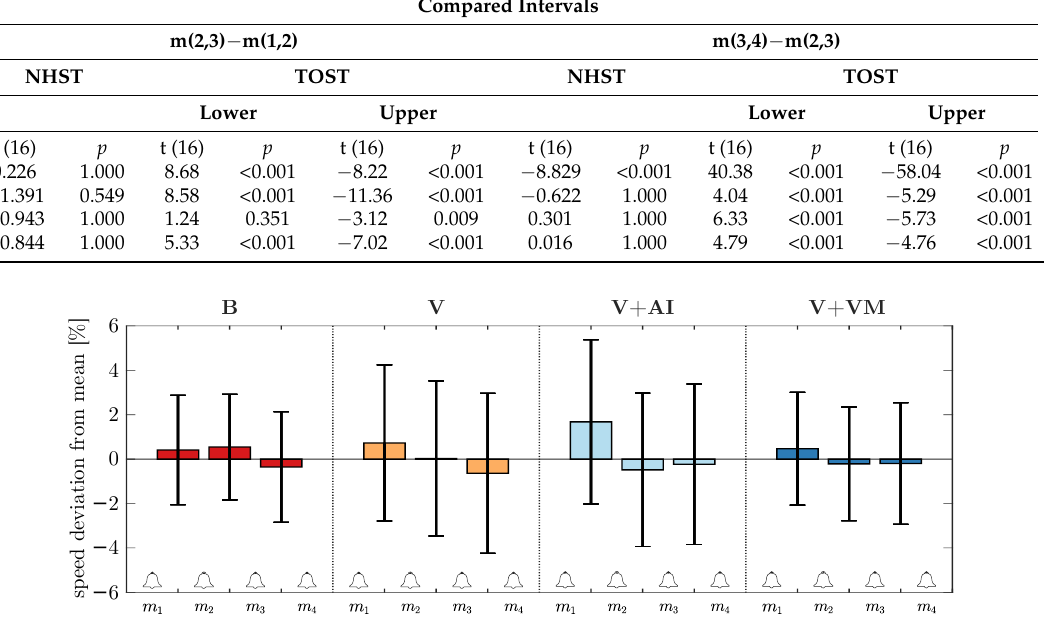
Figure 7. Percentage speed deviation from the mean during active AMs, sorted by